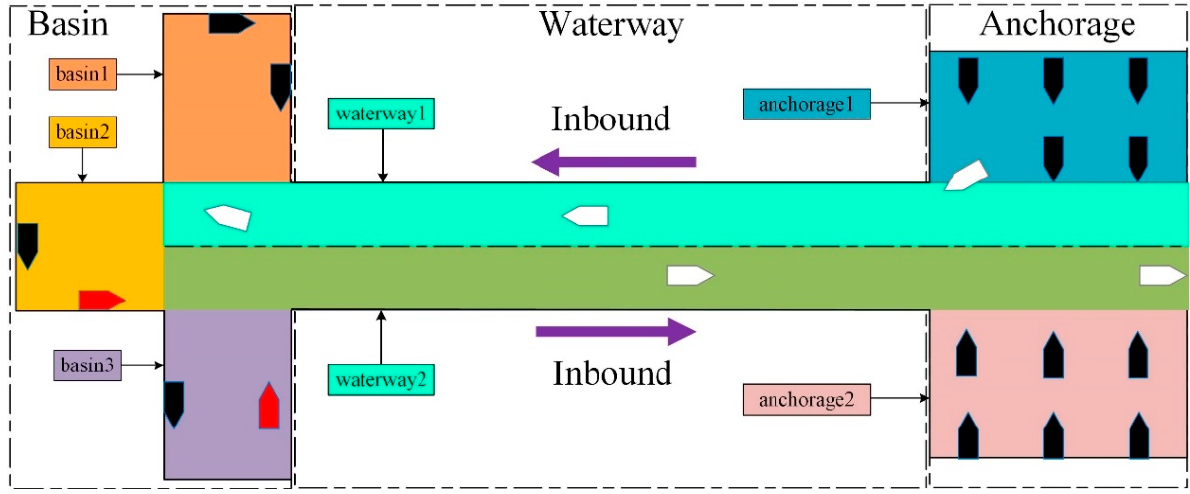
Figure 2. Schematic diagram of the flow of ships entering and leaving the port. Ships with red marks are in a maneuvering state; ships with white marks are in a normal-speed sailing state; ships with black marks are in a hoteling state.